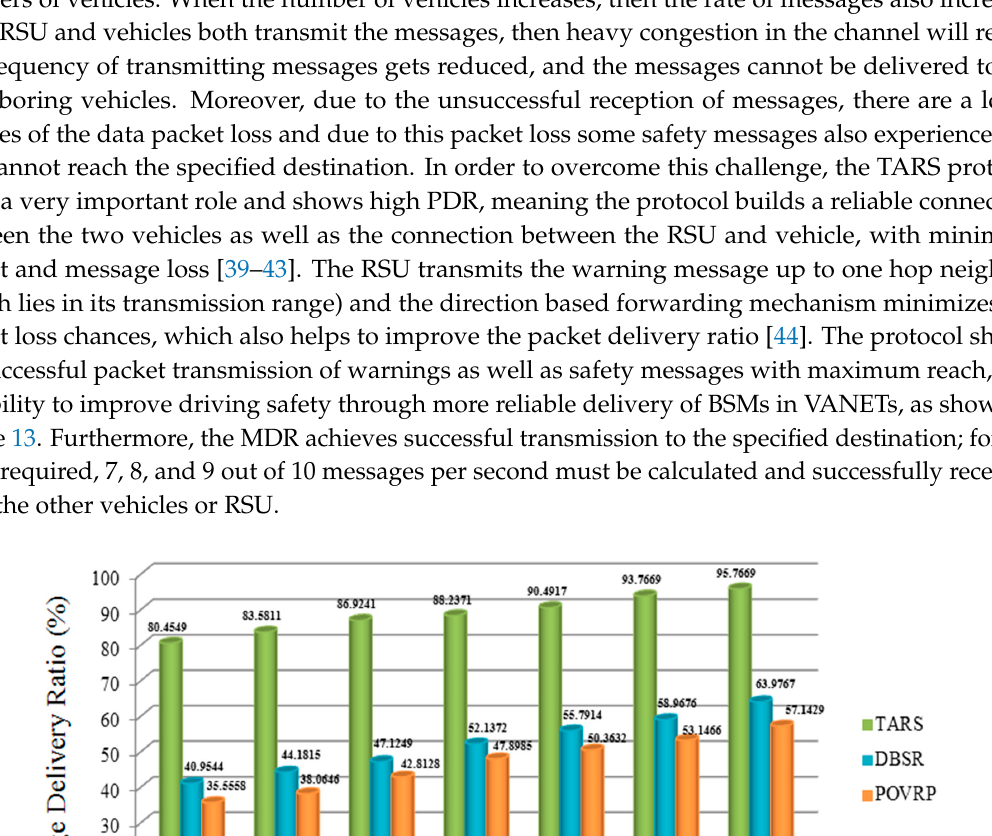
Figure 12. Average Delay in the highway scenario.